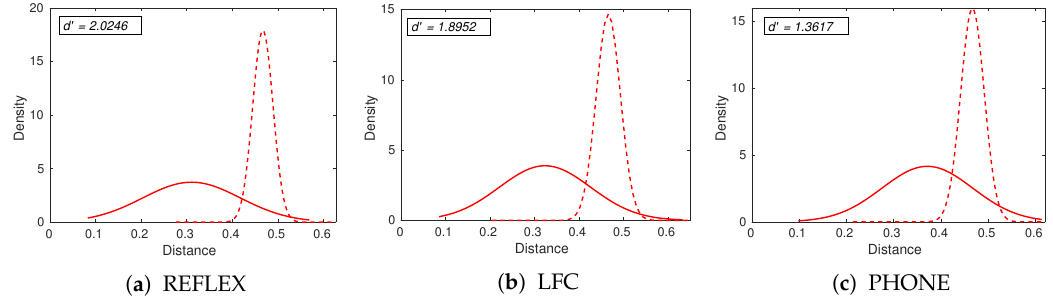
Figure 6. Normal distributions fitted to the normalized histograms of Hamming distances of matching (solid lines) and non-matching (dash lines) iris pairs are shown for three test image datasets.